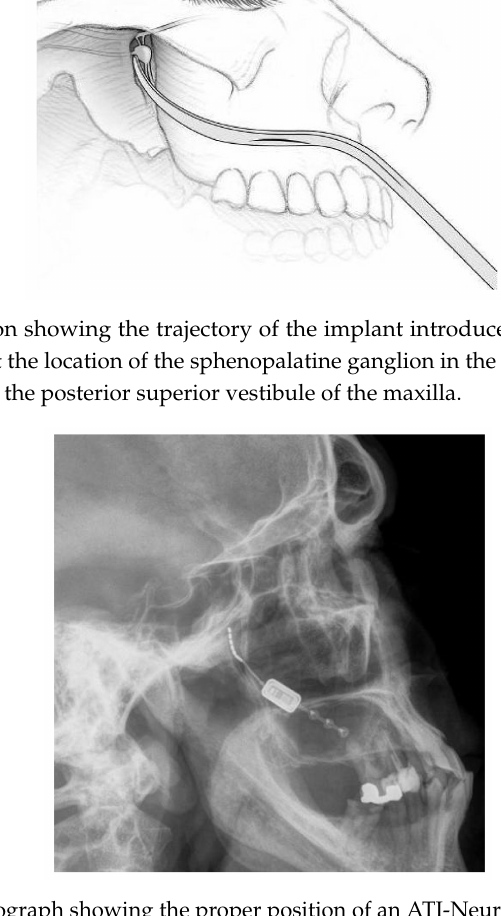
Figure 3. A lateral radiograph showing the proper position of an ATI-Neurostimulator with electrodes within the pterygopalatine fossa and fixation to the posterior maxillary